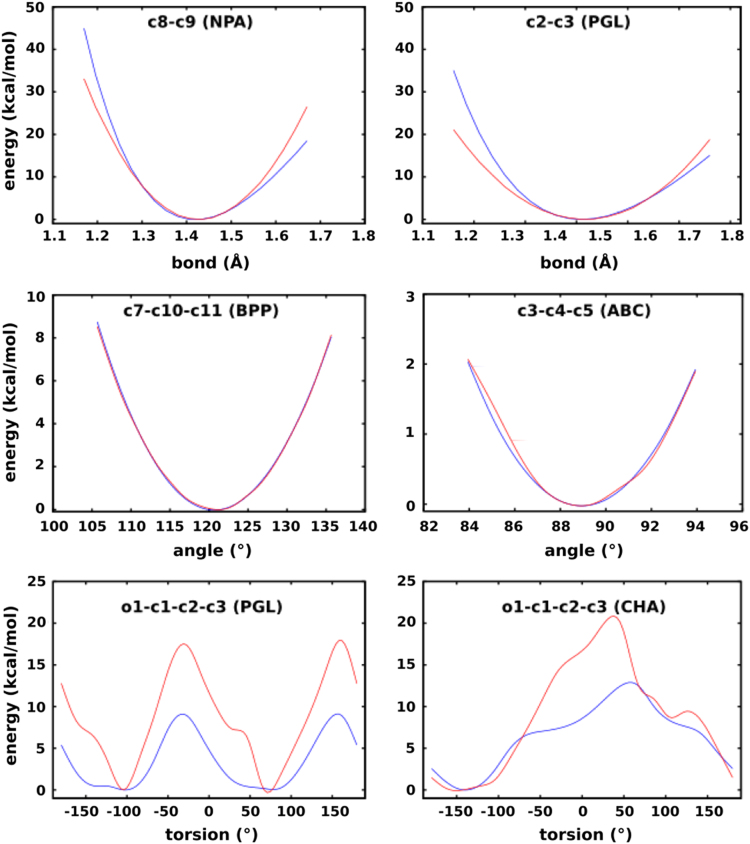
Representative potential energy curves for bond vibrations, angle bending and bond torsion (blue: QM; red: MM). See Figs. S1 and S2 in Supplementary Data for the assignment of atom labels.